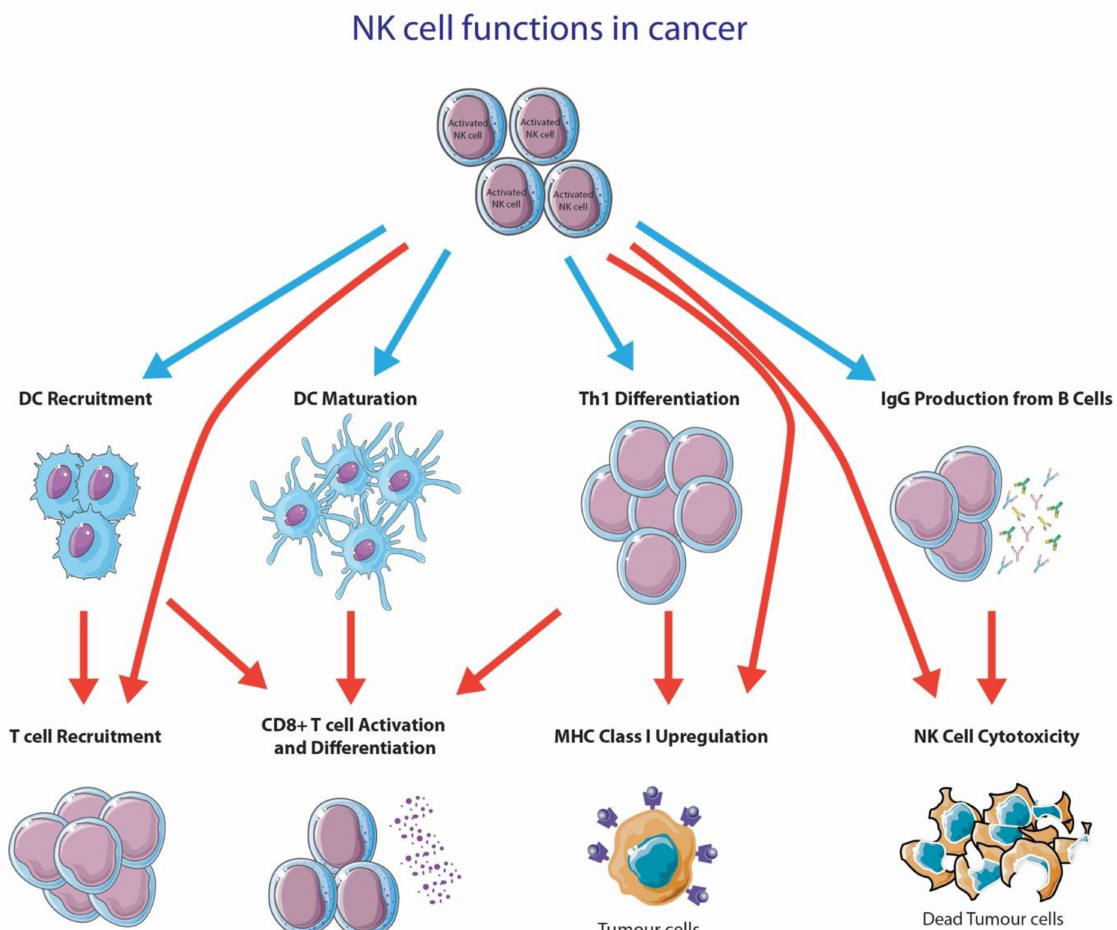
Figure 2. NK cell functions in cancer. This figure was created using Servier Medical Art templates, which are licensed